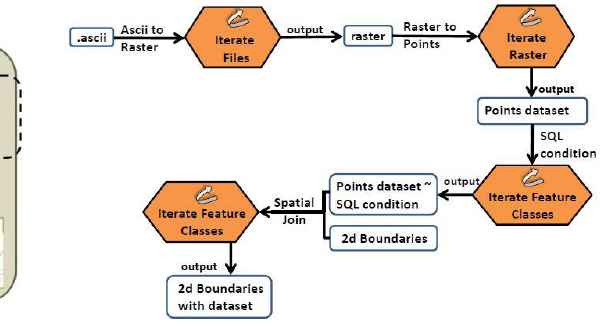
Figure 4. Study workflow